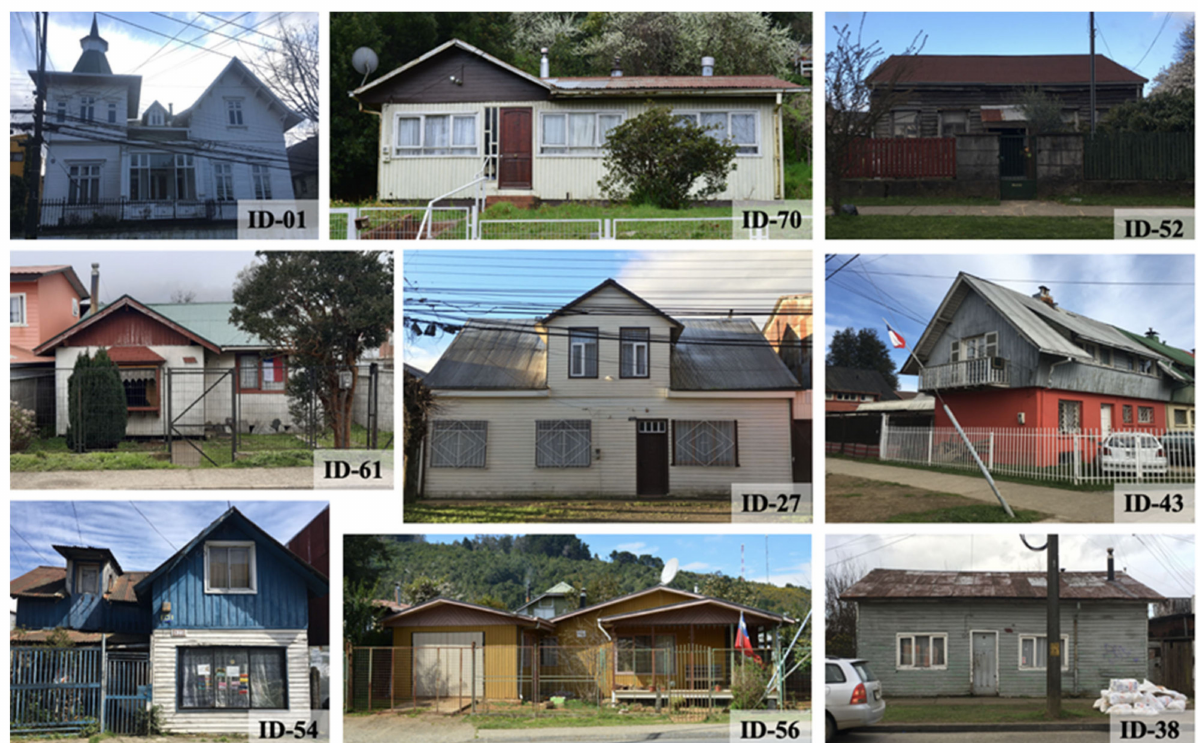
Figure 3. A random selection of the 72 case studies under